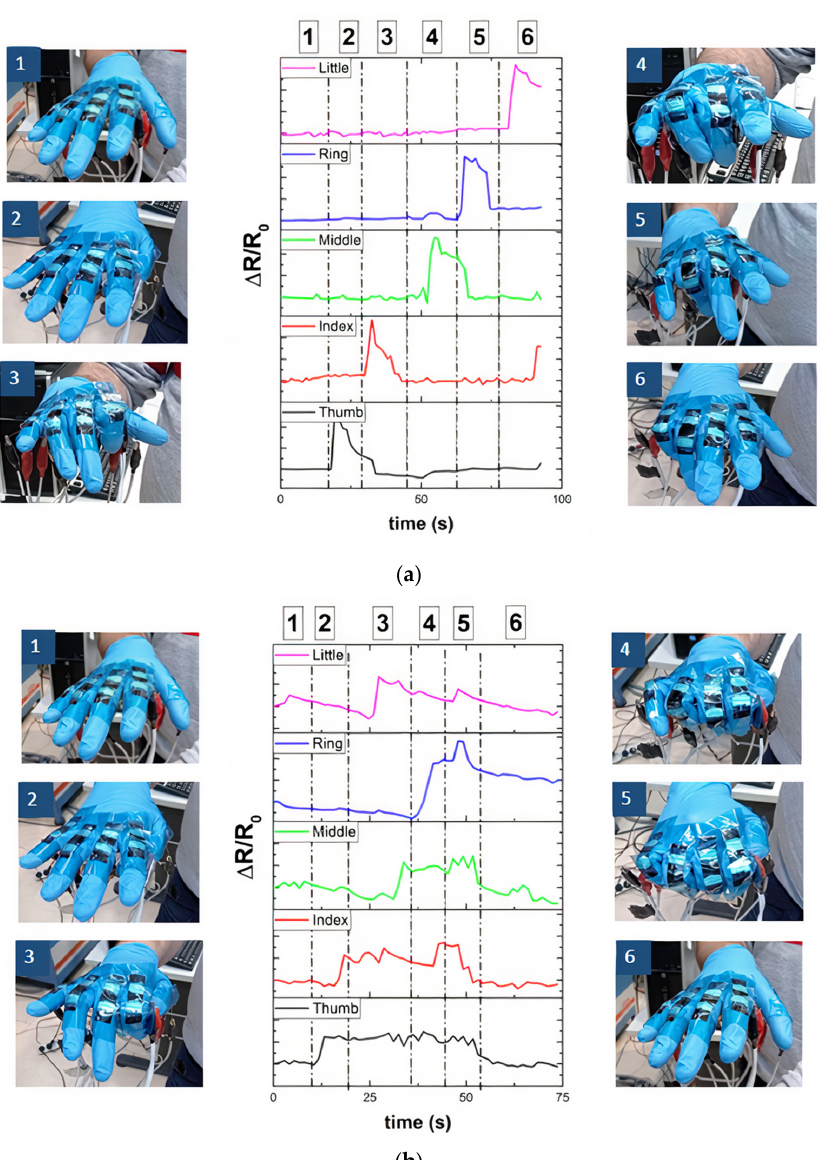
Figure 7. Electromechanical measurements of finger motion monitoring in the case of ( a ) fingers closing and opening and ( b ) closing fingers into a